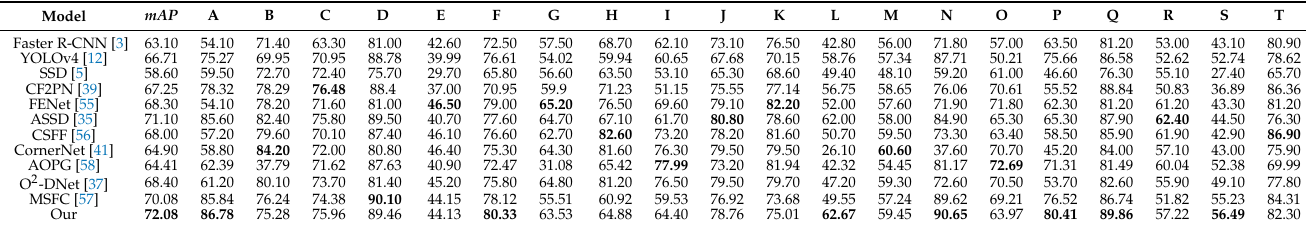
Table 4. Accuracy comparison of our proposed model with other advanced models available, using the DIOR